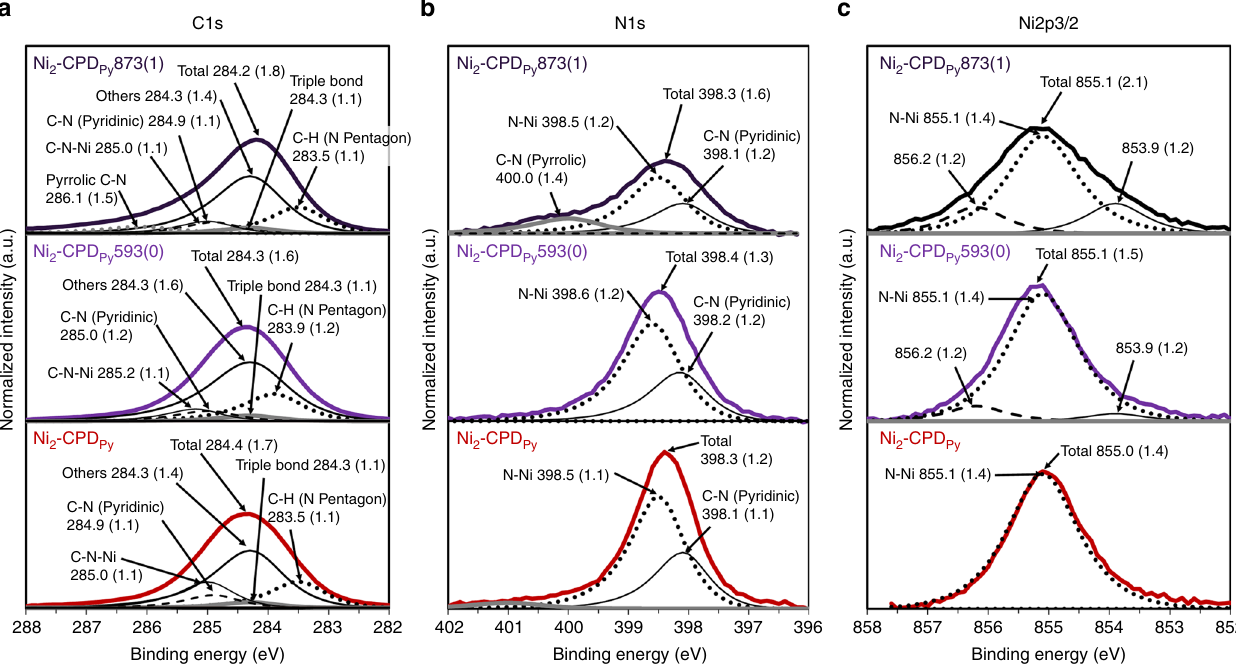
Fig. 4 X-ray photoelectron spectroscopy results of Ni 2 -CPD Py and heat-treated samples. a C1s, b N1s, c Ni2p 3/2 . Numbers before parenthesis indicate binding energy in eV. Numbers inside the parenthesis indicate FWHM of spectra. In a and b , experimentally obtained peaks are deconvoluted into several peaks determined by theoretical calculations (Supplementary Fig. 16). In c , FWHM of the N – Ni peak is determined as 1.4 eV from the result of Ni 2 -CPD Py , and the broadened parts in the heat-treated samples were deconvoluted into three peaks including two additional peaks that have lower (853.9 eV) and higher (856.2 eV) binding energies than that of N –